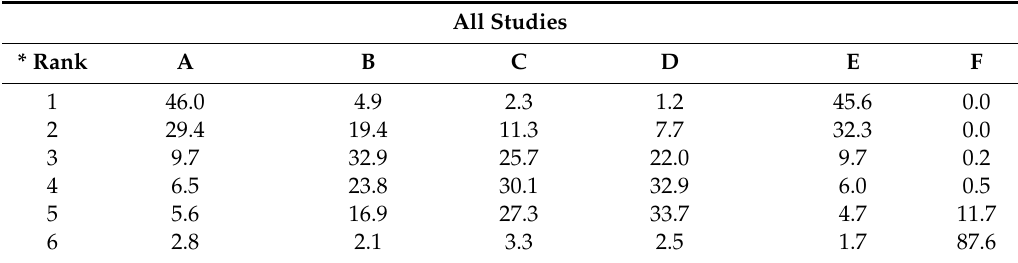
Figure 6. Hazard ratio and 95% credible intervals relative to control. HR < 1 means the regimen is better compared to the control. ( A ) All studies. A: MMC 20 mg + Ara-C 200 mg (maintenance). B: MMC 10 mg (induction). C: Epirubicin 20 mg (induction). D: MMC 40 mg (single instillation). E: Pirarubicin 30 mg (single instillation). F: Control. ( B ) Prospective controlled trials. A: MMC 20 mg + Ara-C 200 mg (maintenance). B: MMC 40 mg (single instillation). C: Pirarubicin 30 mg (single instillation). D: Control.